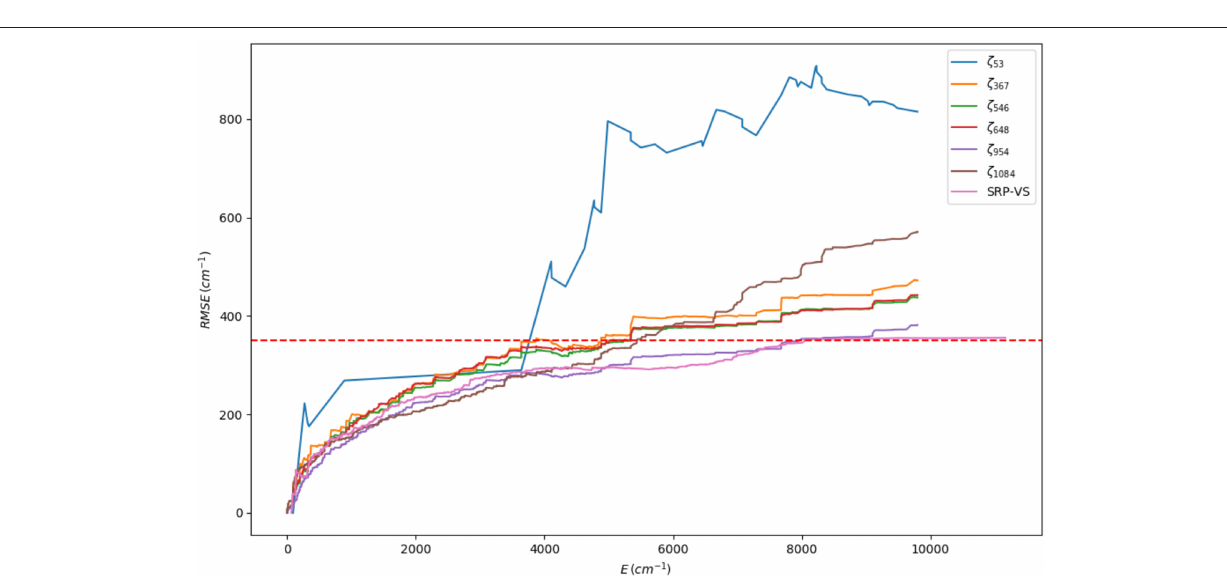
of the potential energies along two of these trajectories. As it can be observed, the PM7 largely deviates from the reference calculation both in their relative values and the phase, whereas SRP-PES follows closely the ab initio values. In particular,